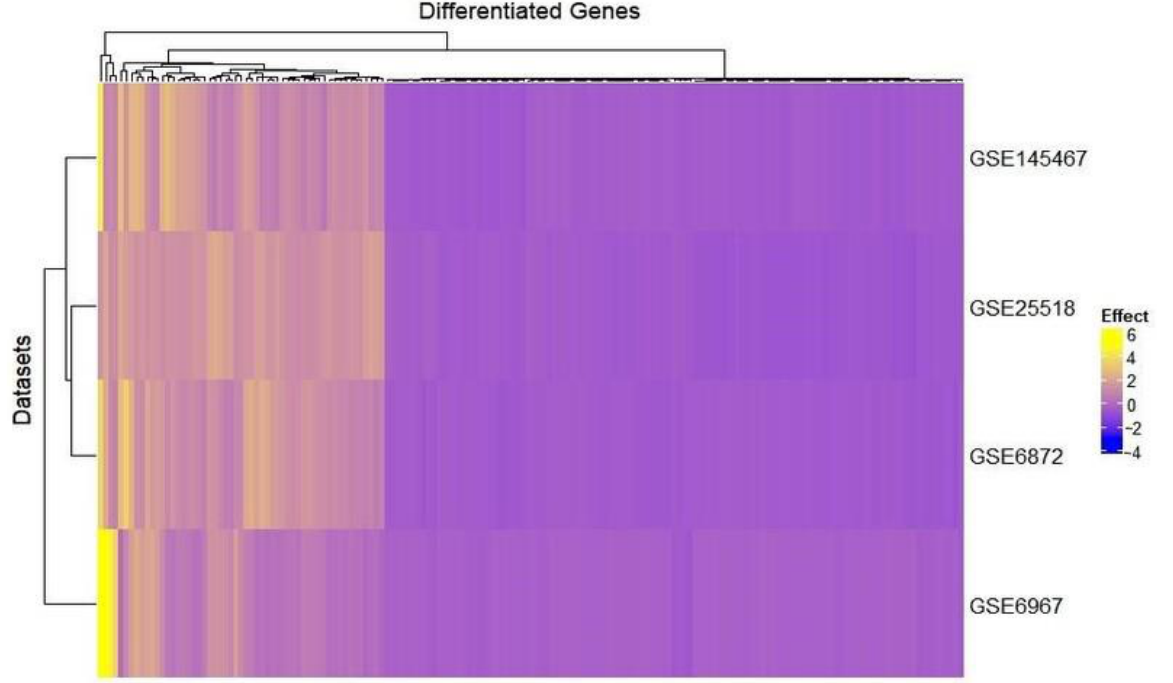
Figure 3. Heatmap of the four datasets of teratozoospermia and azoospermia showing the expression of significantly expressed differential genes as shown by R software using the complete heat package of R. Effect value refers to the change of the log ratio of gene expression compared to the control or study-wide mean or median. Teratozoospermia consisted of the datasets GSE6872 and GSE6967, whereas azoospermia consisted of the datasets GSE145467 and GSE25518. The expression pattern across different samples has been shown with the help of Figure S2. Figure 4 represents the volcano plots of significant genes of the four datasets in- cluded in our study. A volcano plot is a type of scatterplot that shows statistical significance ( p -value) versus the magnitude of change (fold change). It also allows for a quick visual identification of genes with large fold changes that are also statistically significant. The red dots in the figure represent significantly over-expressed genes, the green dots represent significantly under-expressed genes, and the grey dots represent the genes that were not differentially expressed (Figure